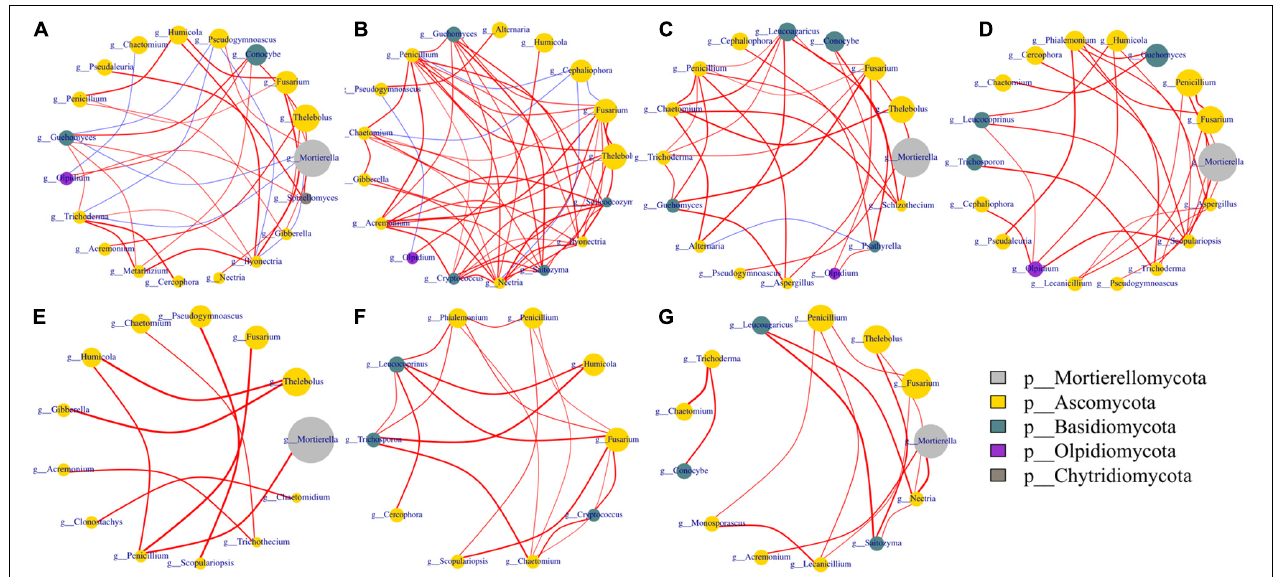
FIGURE 7 | Networks of co-occurring fungal genera. Co-occurrence network was performed using the top 20 abundant genera of bacterial and fungal communities based on Spearman’s rank analysis ( ρ > 0.6) and significant correlations ( p < 0.05). The size of circles at nodes represents relative abundance, the thickness of each edge is proportional to the value of Spearman’s correlation coefficients, and node color represents taxonomy at the phyla level. Edges indicate co-occurrence between nodes colored either blue for negative or red for positive. Treatments included A, non-treated control; B, fenaminosulf; C, kasugamycin; D, dazomet. Numbers 1, 2, and 3 represent samples collected at 14, 55, and 110 days after soil treatment, respectively. (A) A1, A2, A3; (B) B1, B2, B3; (C) C1, C2, C3; (D) D1, D2, D3; (E) A1, B1, C1, D1; (F) : A2, B2, C2, D2; (G) A3, B3, C3,